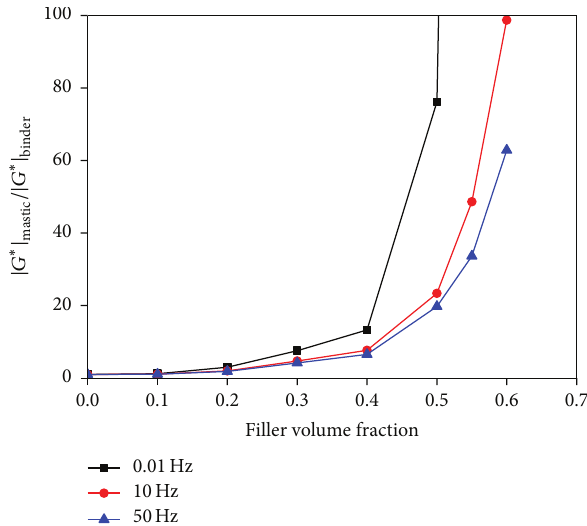
Figure 7: Experiment data and converted master curve of mastic. Table 5: Fitting parameters of the master curve of mastic. Asphalt